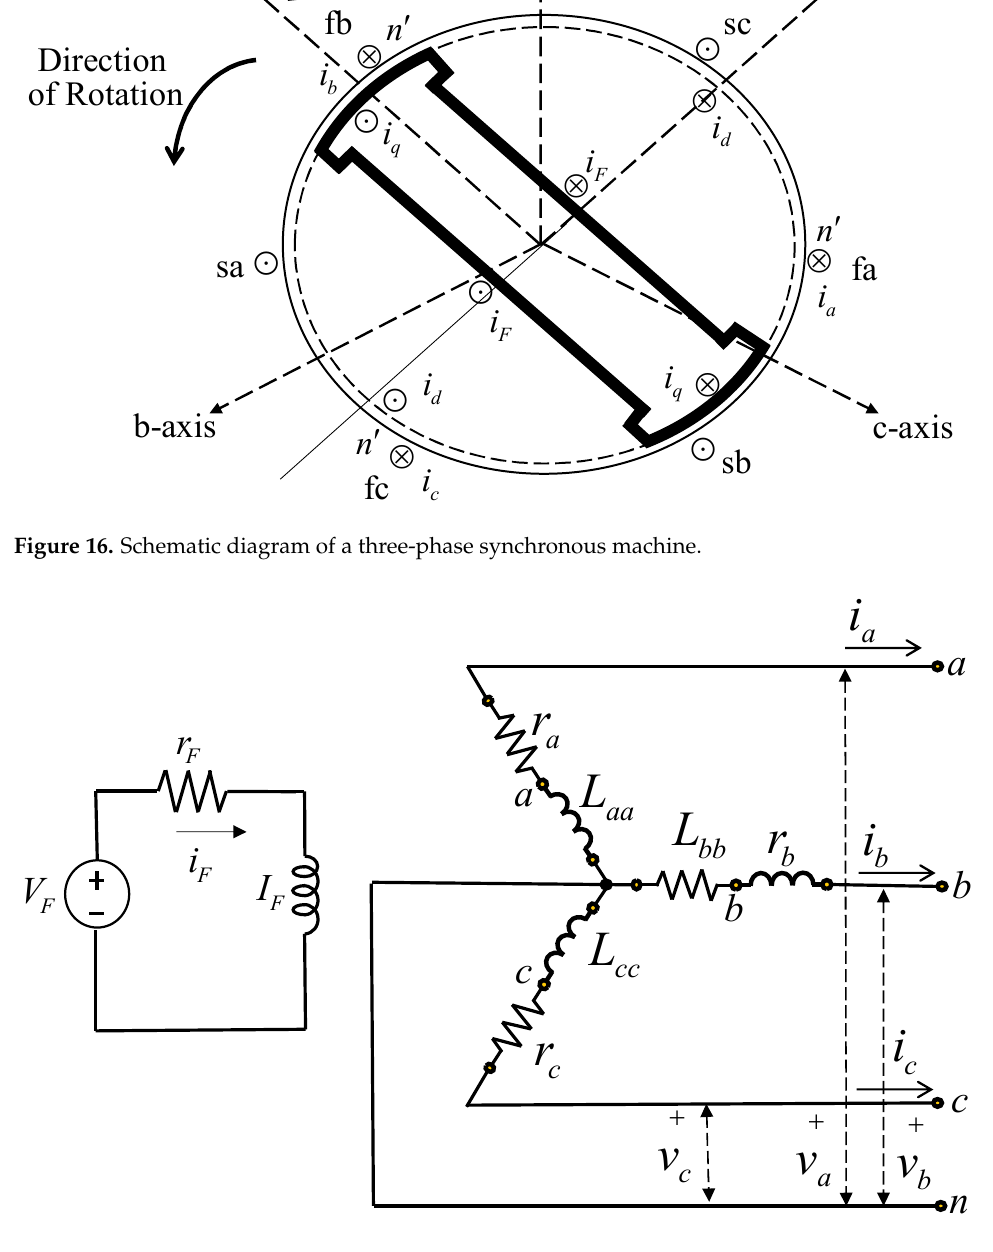
Figure 17. Stator and rotor circuits of a synchronous Fig. 15 . Stator and rotor